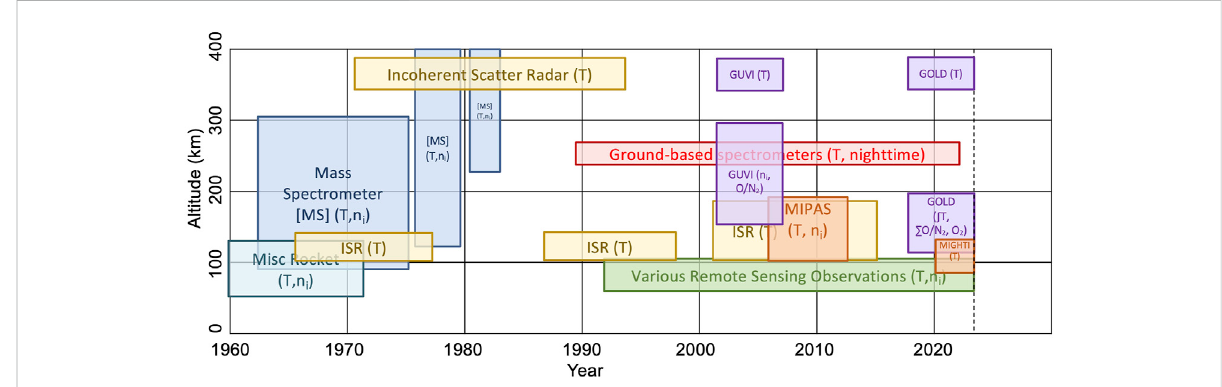
(campaign-based operation, only ~3 sites, daytime only, requires special processing), ground-based airglow measurements (only at ~250 km altitude, nighttime, limited geographic coverage, sporadic temporal coverage), and ground-based resonance fl uorescence lidars routinely measure temperature from ~80 km up to ~115 km at nighttime (Yuan et al., 2021), with occasional temperature observations reaching ~140 km and above (Chu et al., 2011; Liu etal., 2016). Further, importantforimprovingtheMassSpectrometer Incoherent Scatter radar or MSIS series of empirical models with current and future thermospheric composition and temperature measurements, is the complicating factor that measurement techniques often use MSIS itself as an initial guess or for ancillary parameters needed in the retrieval (e.g., Michelson Interferometer for Passive Atmospheric Sounding (MIPAS), Bermejo-Pantaleón et al., 2011; Global Ultraviolet Imager (GUVI), Meier et al., 2015). Thus, there is a need to expand existing and develop new techniques for measuring and retrieving thermospheric temperature and composition, especially between the 100 km and 200 km altitude region, which has strong vertical gradients and a strong in fl uence on higher altitudes in the T-I. In the absence of well-resolved global temperature and composition measurements the community has often turned to the empirical Mass Spectrometer Incoherent Scatter Radar (MSIS ® ) class of models (Hedin et al., 1977a; Hedin et al., 1977b; Hedin, 1987; Hedin, 1991; Picone et al., 2002) to understand and validate thermospheric composition and temperature phenomena in the 100 – 200 km region. MSIS recently went through a major reformulation and upgrade from NRLMSISE-00 to NRLMSIS version 2.0 by Emmert et al. (2021), using extensive new datasets from the ground to ~100 km altitude (green box labeled “ Various Remote Sensing Observations ” , post-2000 in Figure 1). Further, above ~250 km new satellite drag-derived mass densities were used to tune and recalibrate thermospheric atomic oxygen.